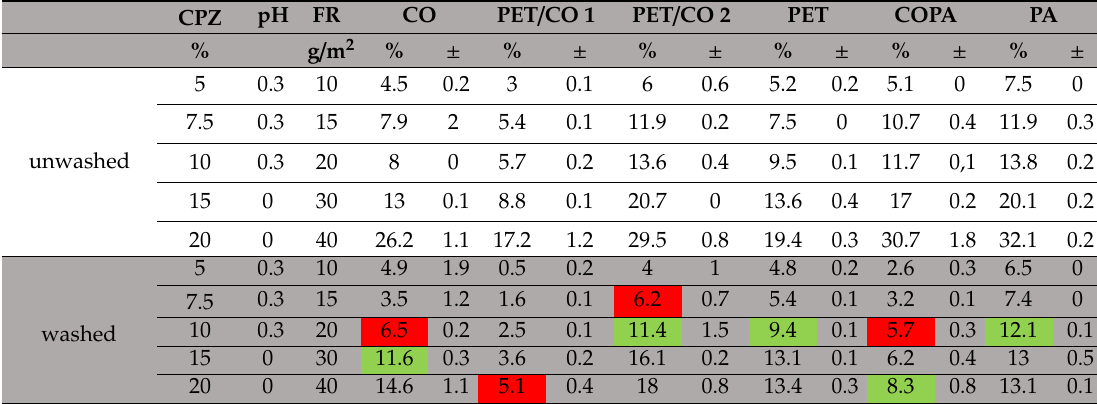
Table A1. Used concentration of CPZ and pH-value of the HCl solution for finishing of the textiles.